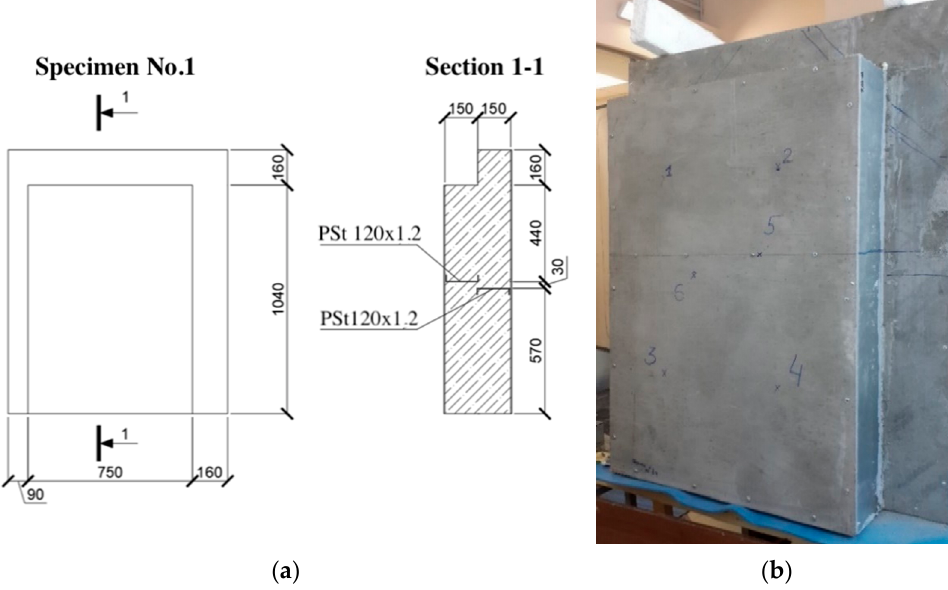
Figure 1. First specimen for testing. ( a ) Specimen dimensions; ( b ) specimen photo.